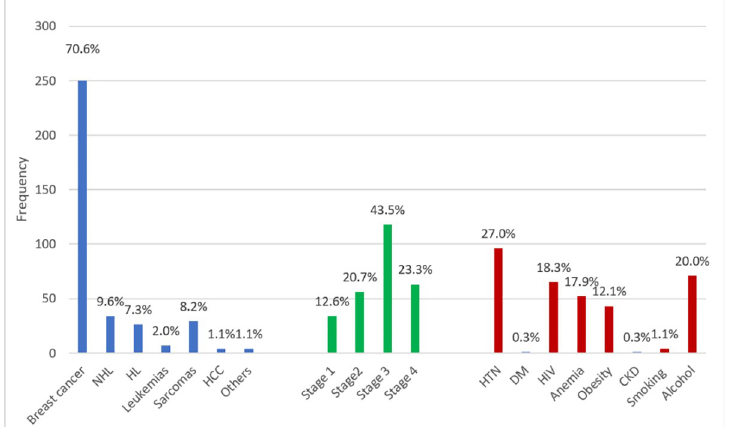
Fig 3. Cancer profile and cardiovascular risk factors. NHL: non-Hodgkin’s lymphoma, HL: Hodgkin’s lymphoma, HCC: hepatocellular carcinoma, HT: hypertension, DM: diabetes mellitus, CKD: chronic kidney disease.